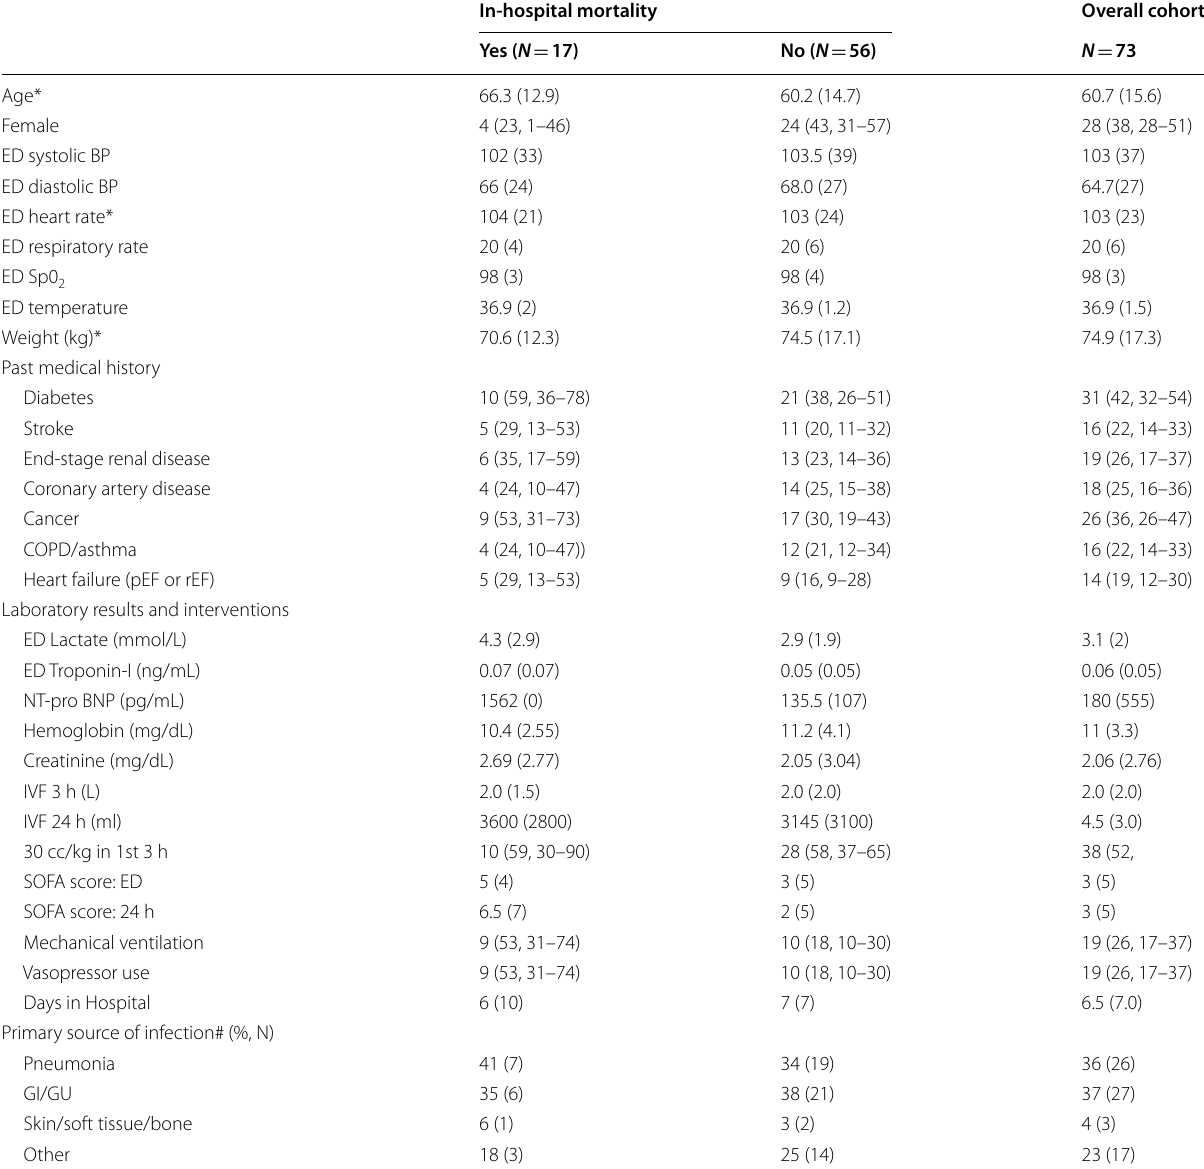
Table 1 Baseline patient